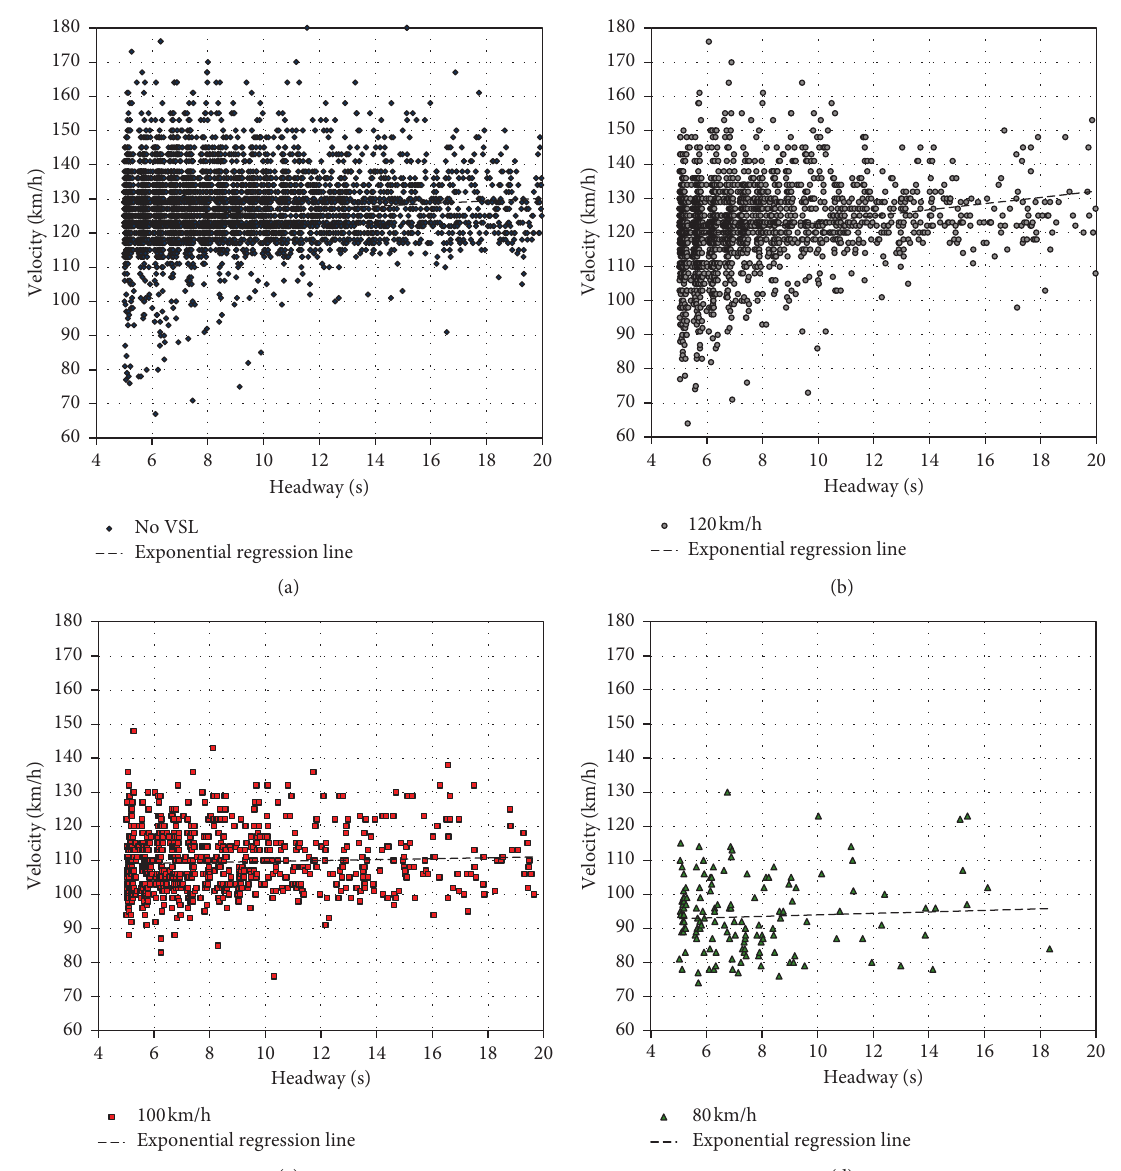
Figure 1: Speed headway of the vehicles on the left lane (headway greater than 5s): (a) uncontrolled state, (b) 120km/h, (c) 100km/h, and (d)